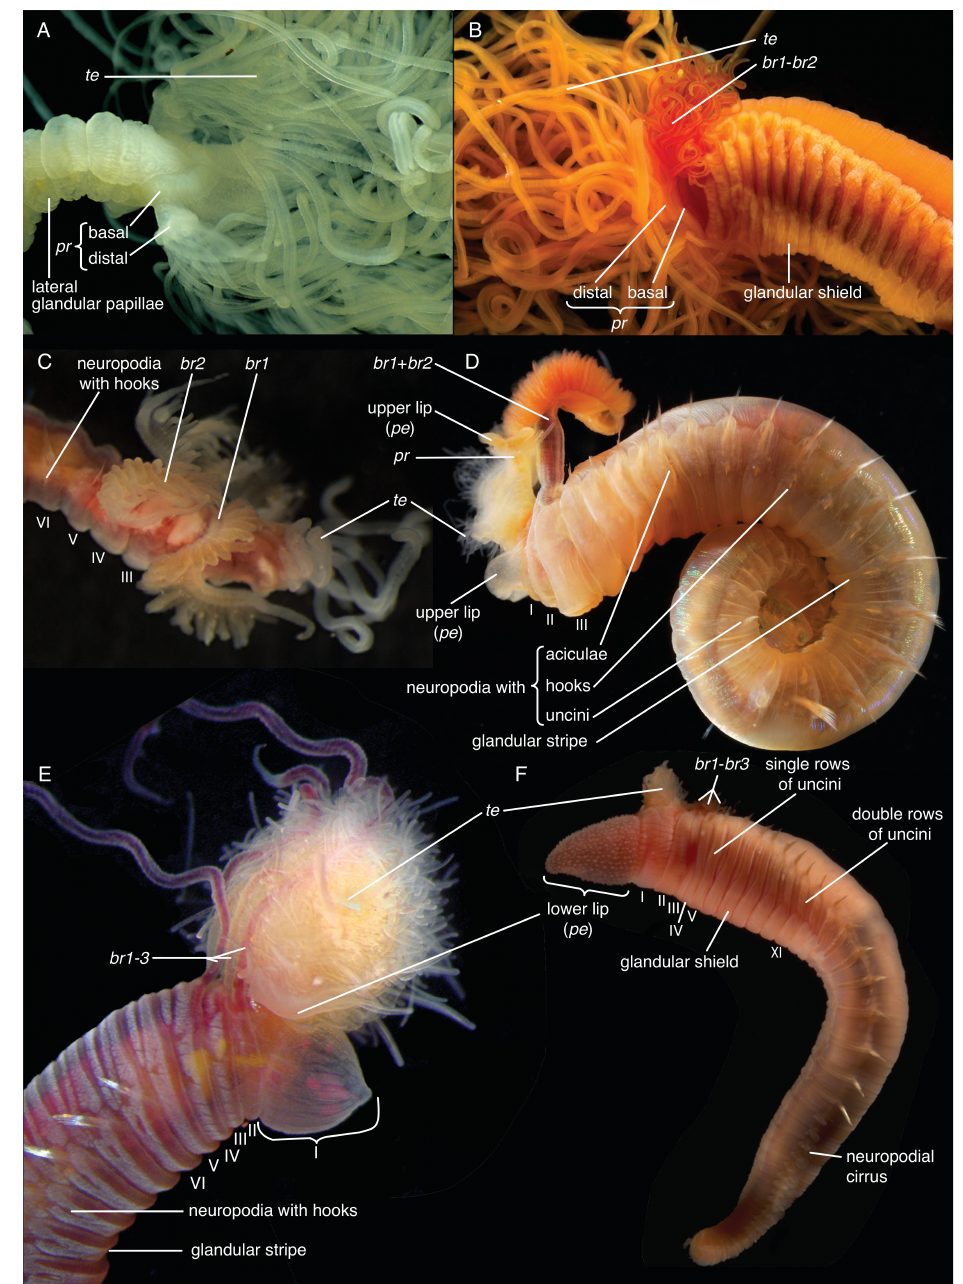
Figure A3. Morphology of Terebellidae and Trichobranchidae. ( A ) Hauchiella renilla (Terebellidae, Terebellinae, Polycirrini, SIO-BIC A1116), anterior body. Note the absence of branchiae and chaetae. ( B ) Thelepus antarcticus (Terebellidae, Thelepodinae, SIO-BIC A2980), anterior body. ( C ) Terebellides sp. LA1 (Trichobranchidae, SIO-BIC A9464), anterior body. This undescribed species di ff ers from other Terebellides species in having well separated branchial lamellae. ( D ) Terebellides sp. from Sweden (Trichobranchidae), whole body in lateral view. The branchiae are fused basally with densely packed lamellae proximally. ( E ) Trichobranchus tribranchiata (Trichobranchidae, SIO-BIC A1123), anterior body. Note the proboscis, here formed by the first segment. ( F ) Artacama crassa (Terebellidae, Terebellinae, Terebellini, SIO-BIC A3151), whole body in lateral view. Note the proboscis, here formed by the peristomial lower lip. Abbreviations: br —branchial pairs, pe —peristomium, pr —prostomium, te —buccal palp or tentacle. Roman numerals designate segment